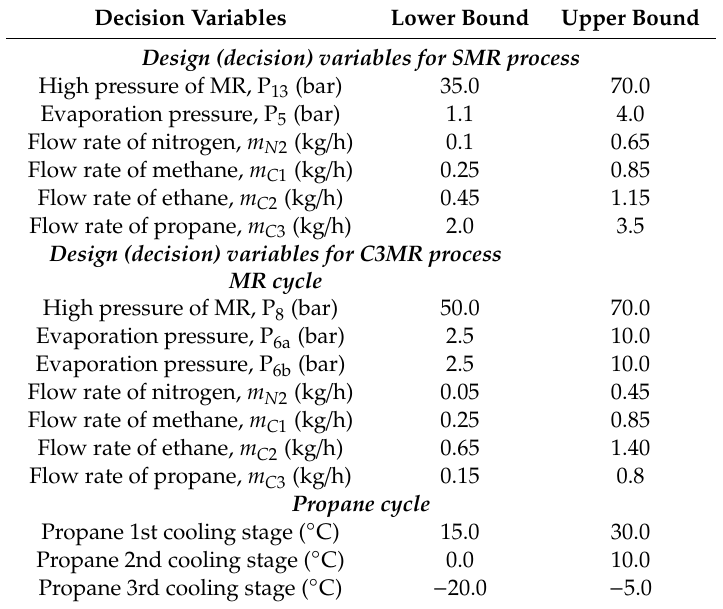
Table 3. Decision variables of the SMR and C3MR processes with their upper and lower bounds. Decision Variables Lower